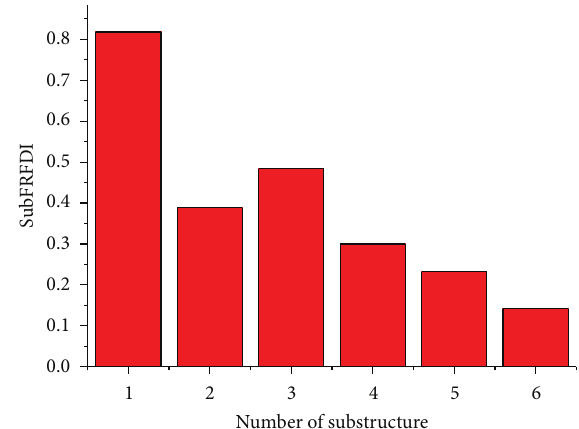
Figure 9: Damage location indices obtained through a substruc- ture-based FRF